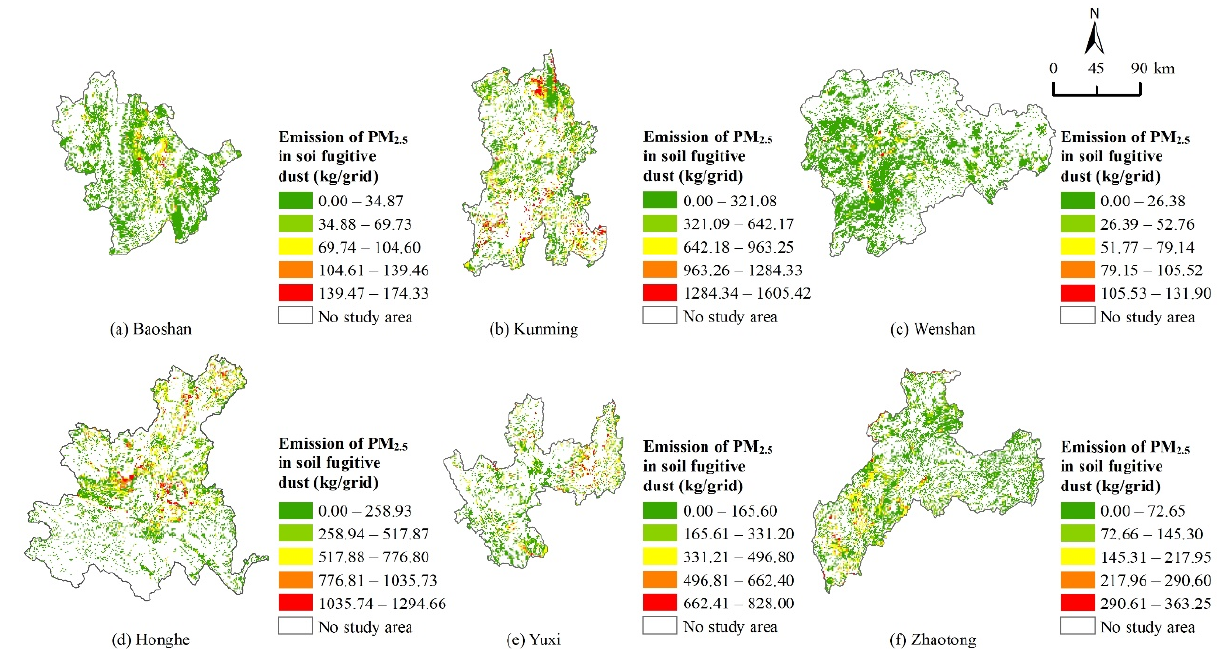
Figure 5. Spatial distributions of the emissions of PM 2.5 in soil fugitive dust in 2018 on a 1 km grid cell.